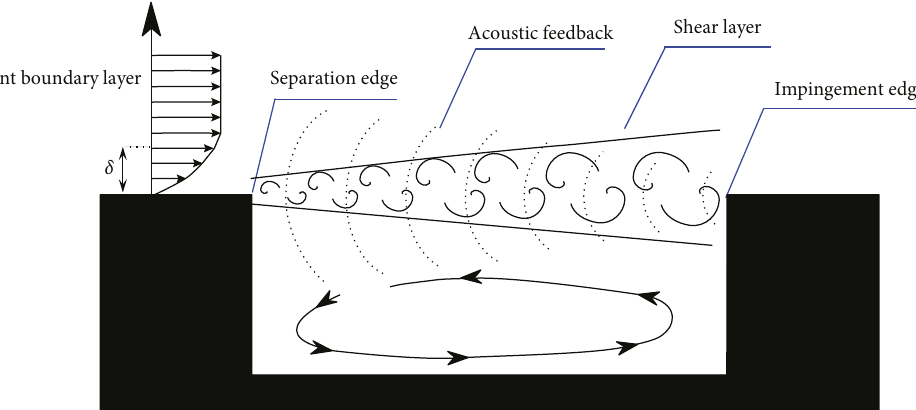
Figure 9: Schematic of the fl ow-induced cavity resonance.